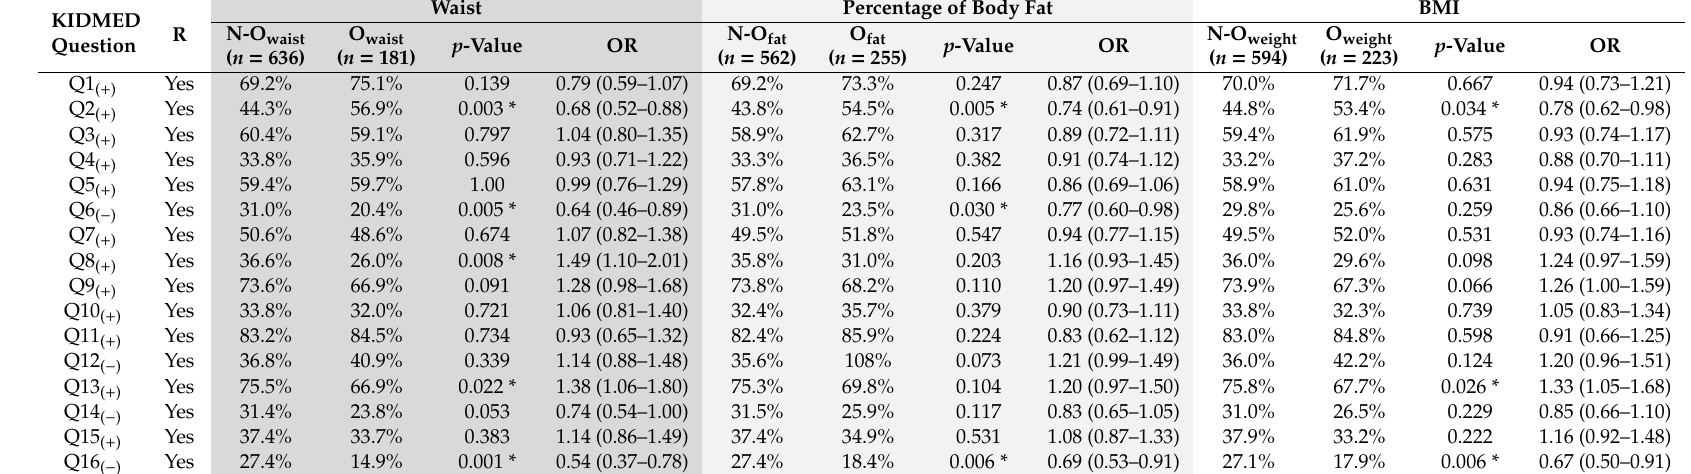
Table 4. Responses in the KIDMED questionnaire in over and non-over girls according to selected body composition parameters.